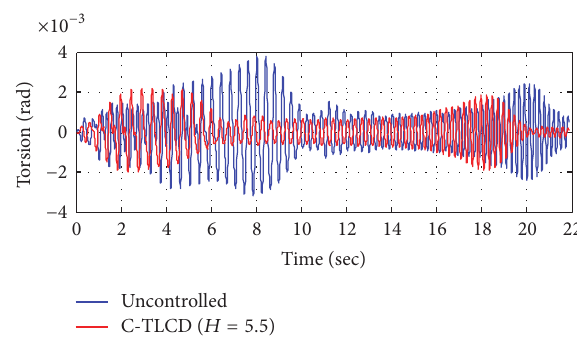
Figure 13: The torsional behavior of the top floor of the structure as a function of time for uncontrolled and controlled structure for 𝐻 = 5.5 cm and 𝛽 = 10 ∘ .